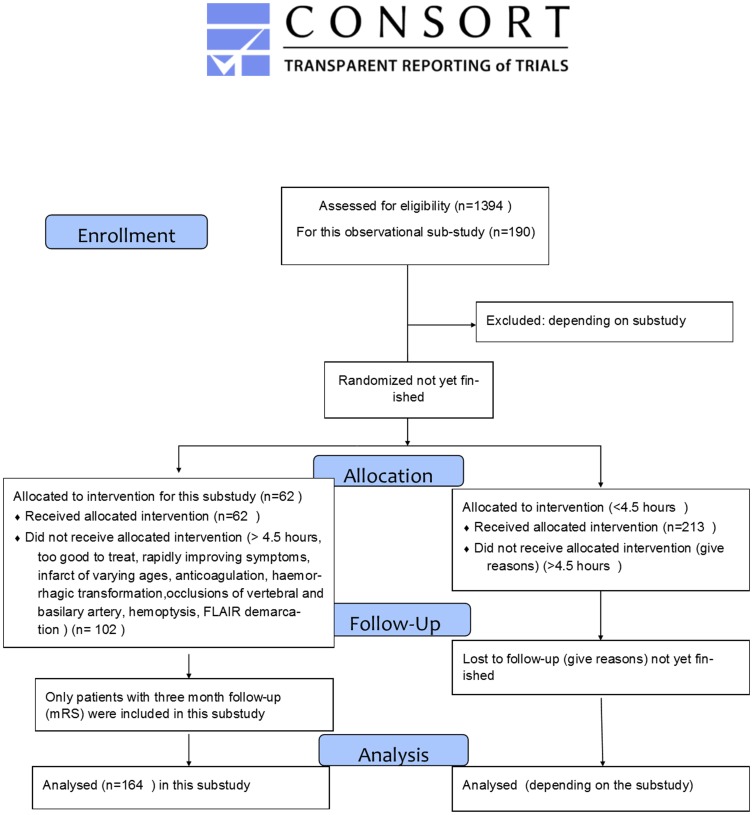
CONSORT 2010 Flow Diagram.